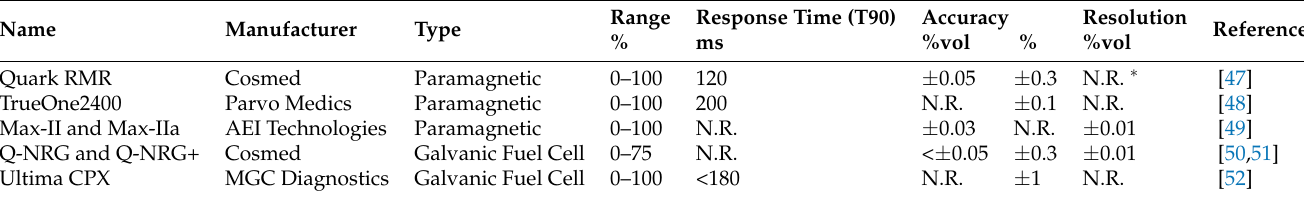
Table 1. Overview of the technical specifications (measurement range, T90 response time, accu- racy, and resolution) of paramagnetic and galvanic fuel cell oxygen sensors of commercial indirect calorimeters as reported by the manufacturers.